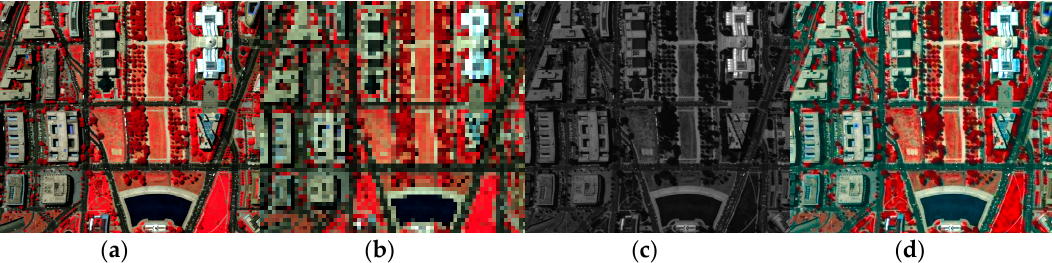
Figure 12. ( a ) RGB composites of the image (bands 102, 56, and 31 for red, green, and blue, respectively). ( b ) Coarse image ( S = 4) ( c ) Panchromatic image. ( d ) Pansharpening result.